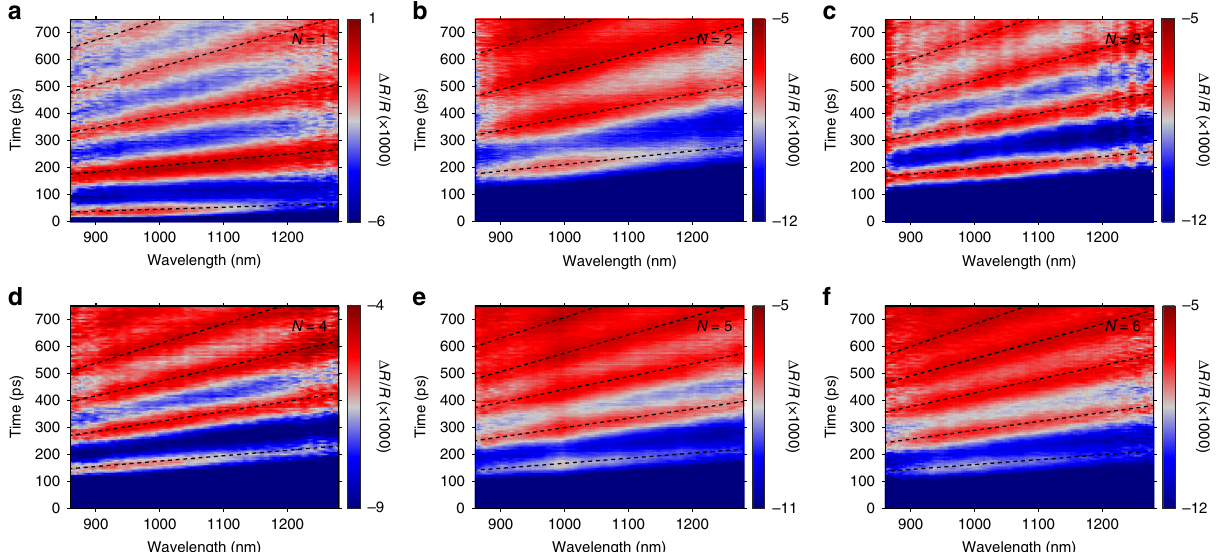
Fig. 2 Transient re fl ection measurements of the 2D RP single crystals. a – e Δ R / R spectral maps for N = 1 – 6, respectively, acquired with 400-nm pump excitation. The scalebar is in unit of Δ R / R (×1000). Fluences used were 0.18, 0.25, 0.25, 0.25, 0.18, and 0.21 mJ cm − 2 ,